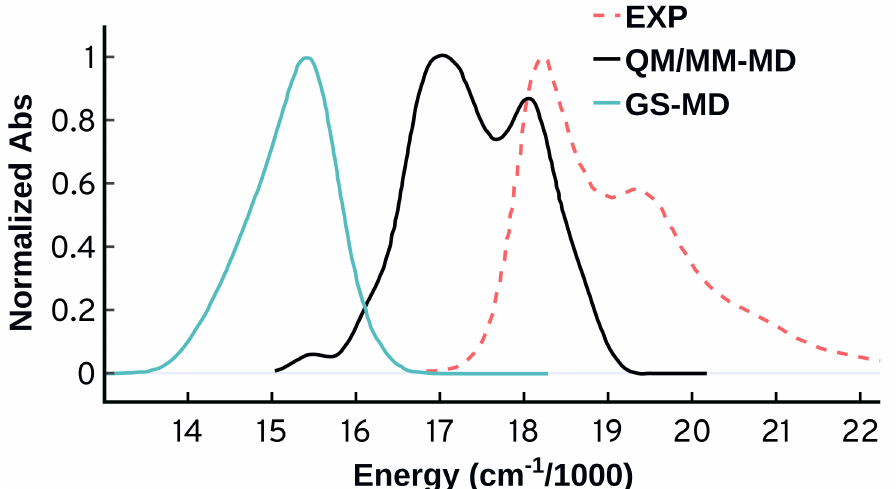
Figure 3. Normalized absorption spectra from the same MD ensemble (50 configurations) using the ADC(2) method in gas phase (GS-MD) and with QM/MM